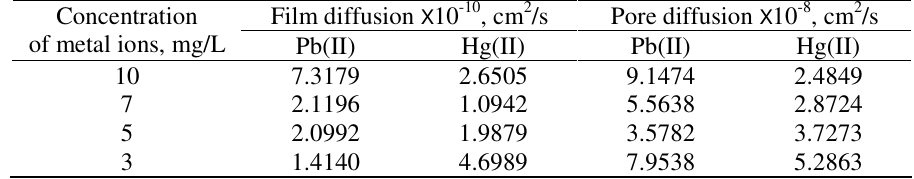
Table 5. Diffusion co-efficient for the simultaneous removal of lead(II) and mercury(II) by